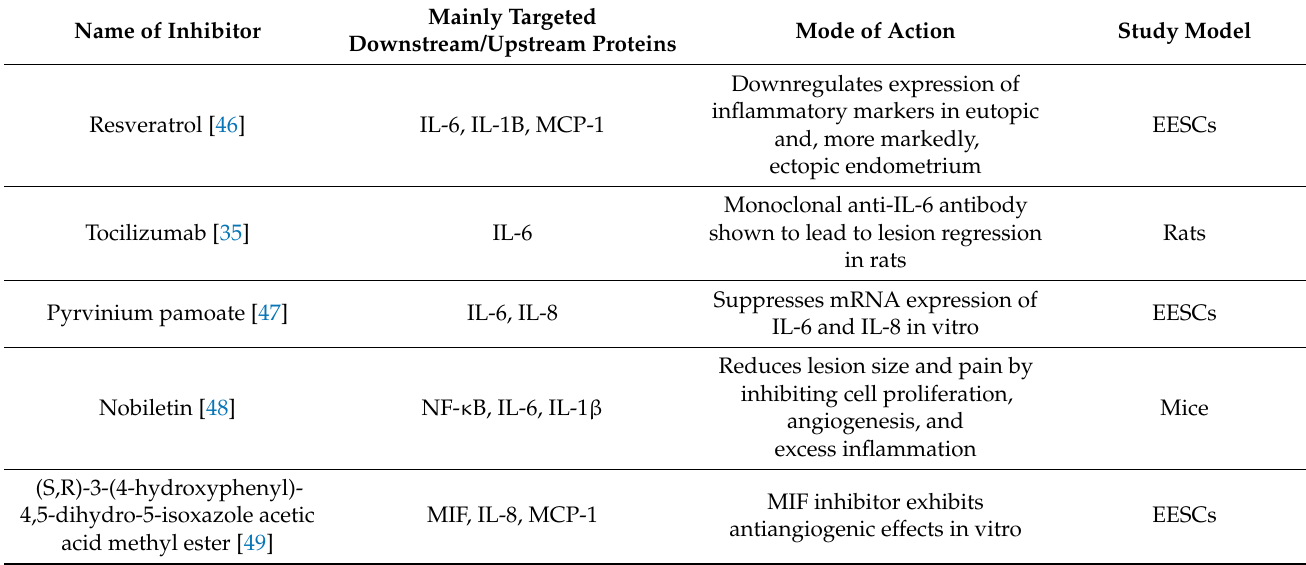
Table 4. List of pharmacological inhibitors that target inflammatory molecules and play an important role in mitigating